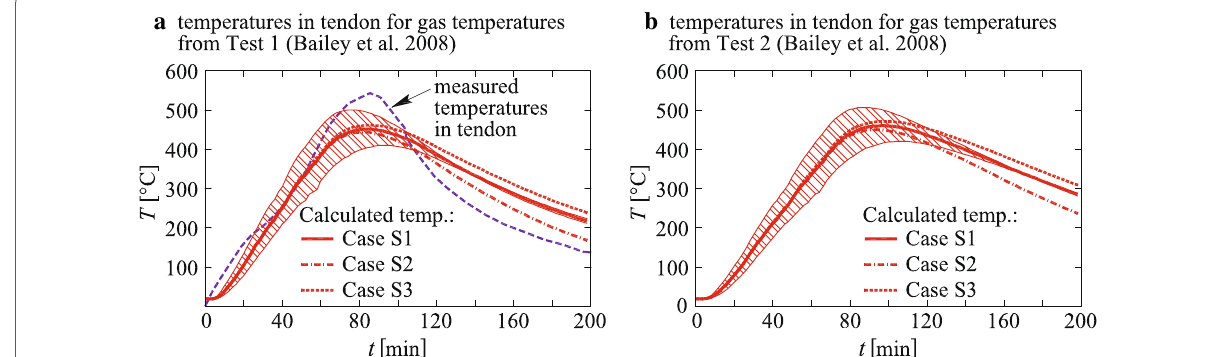
Fig. 7 Development of temperatures in concrete at tendon position with time: a in Test 1, b in Test